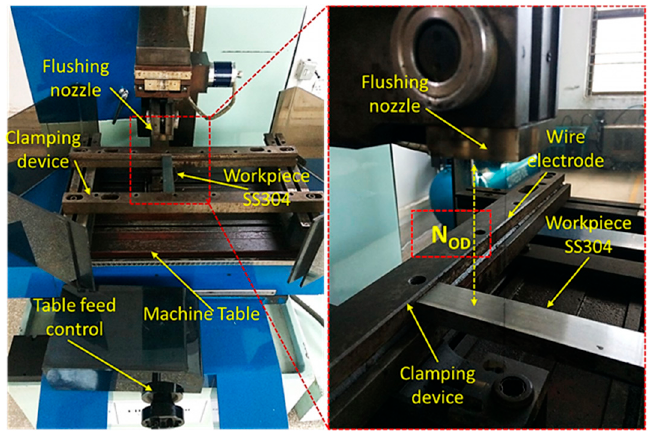
Figure 1. The material composition of SS 304 (Table 1) was obtained by spectroscopy using the ASTM E 167-4 standard procedure. Table 1. Chemical composition of stainless steel 304.